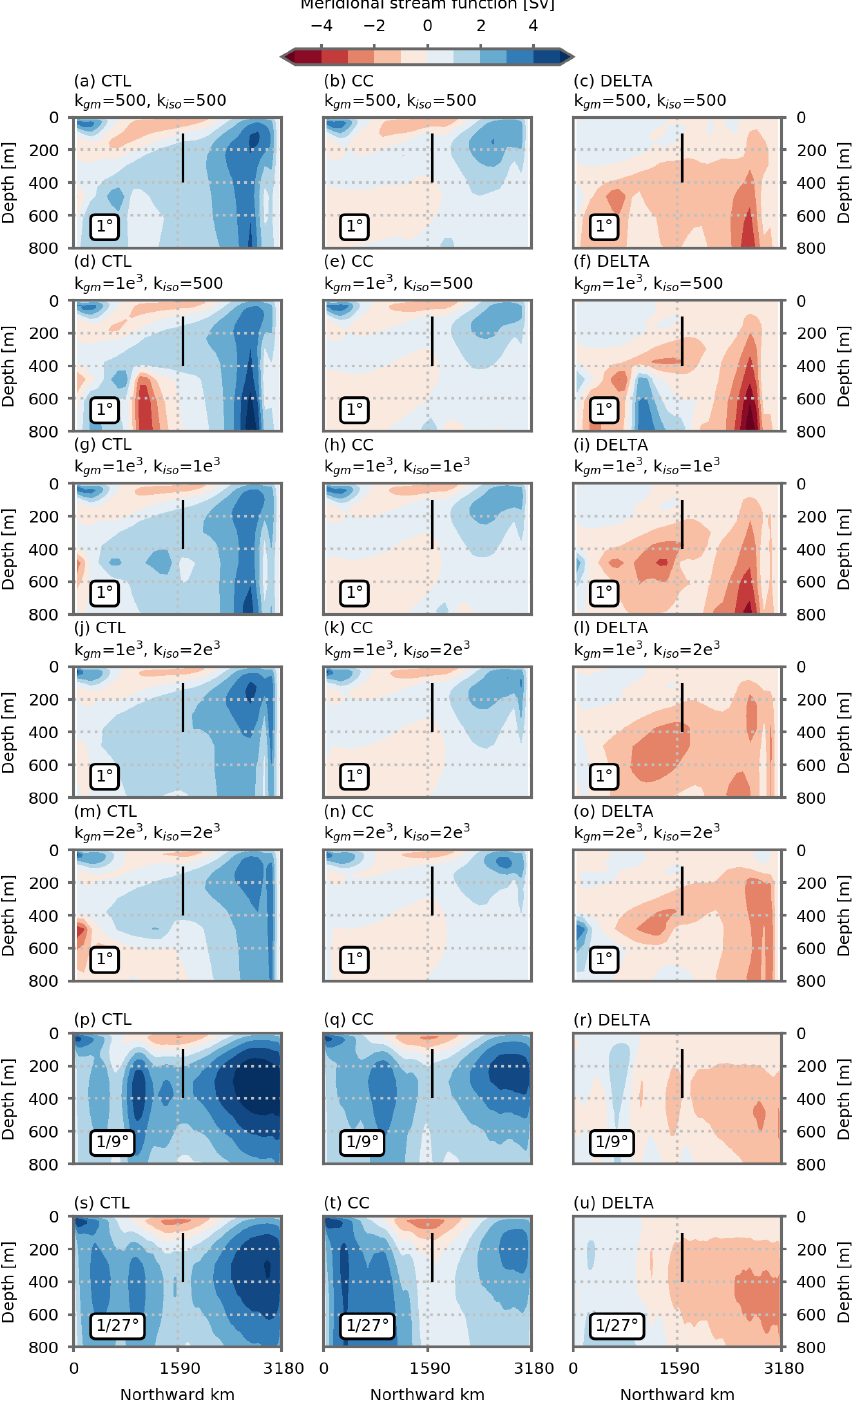
Figure A8. Meridional stream functions (Sv) in the preindustrial control simulation (first column) and climate change simulations (second column) and the difference between the two (third column). Meridional stream functions are computed in z coordinates. The vertical black lines range from 100 to 400m depth and show the area through which we diagnose the water flow between the two gyres. Panels (a) – (o) show the five 1 ◦ resolution configurations, and (p) – (u) show the 1 / 9 and 1 / 27 ◦ resolution configurations. All figures show the average over the last 5 years of the simulations (years 66 to